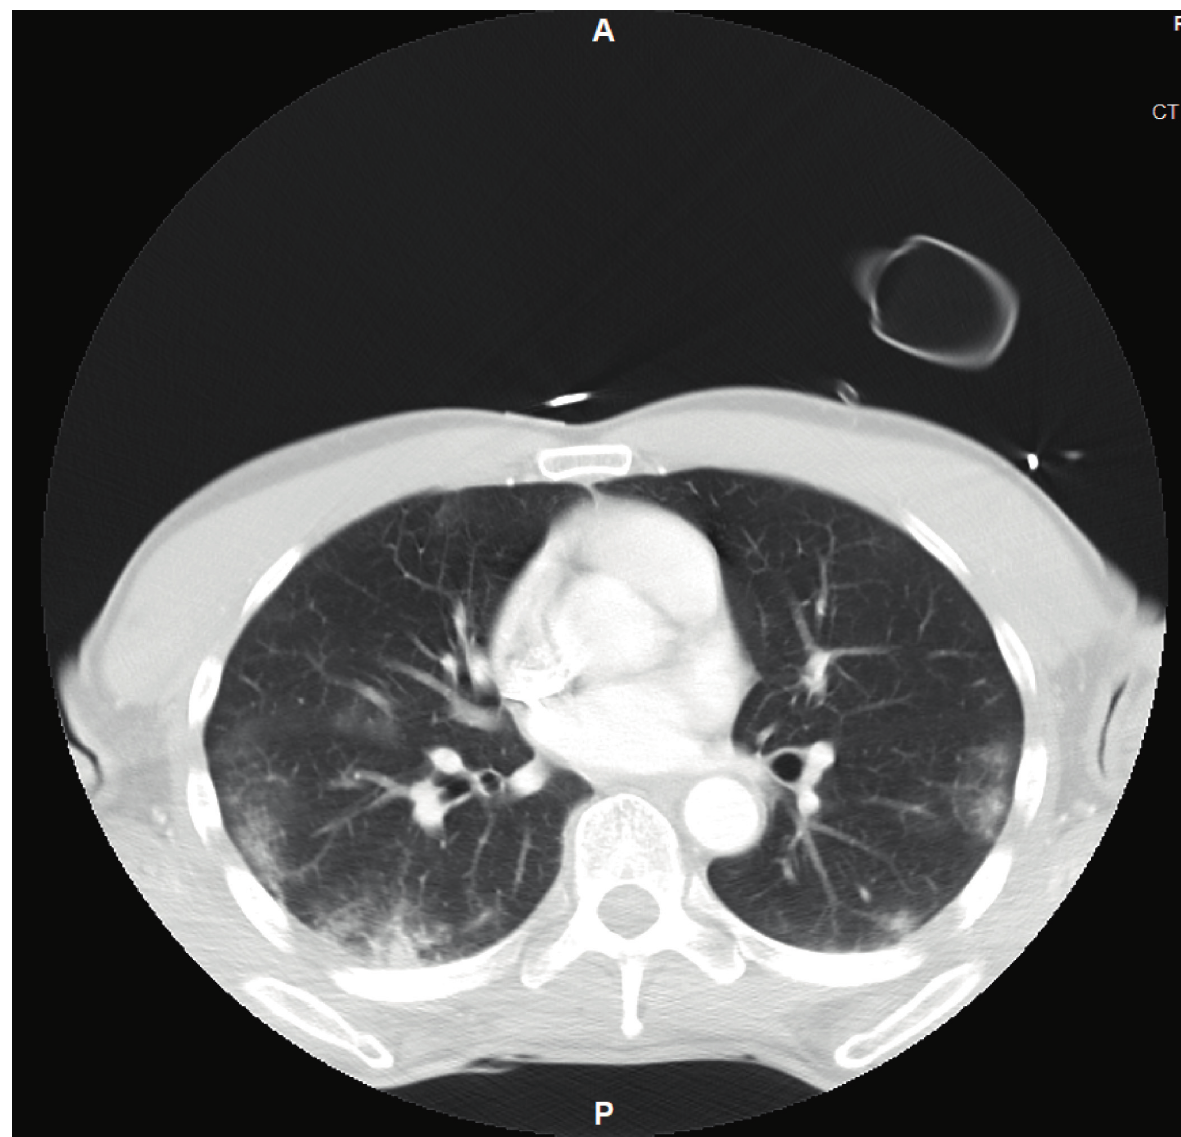
Figure 3: Chest CTof the COVID-19 patient showing patchy and peripheral ground glass opacities mid to lower lobe predominant (taken from another COVID-19-positive patient for